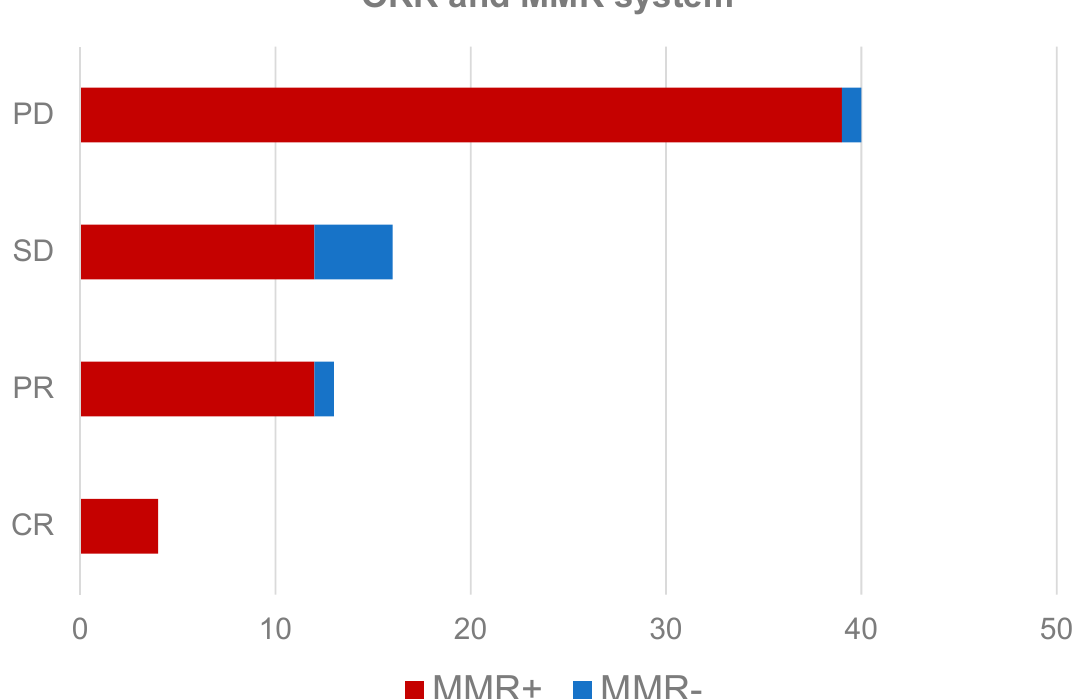
Figure 3. Relationship between objective response rate (ORR) and mutations in the MMR system in patients treated with immunotherapy in NSCLC. MMR+, present expression of MMR system; MMR-, deficiency expression of MMR system; PD, progressive disease; SD, stable disease; PR, partial response; CR, complete response.